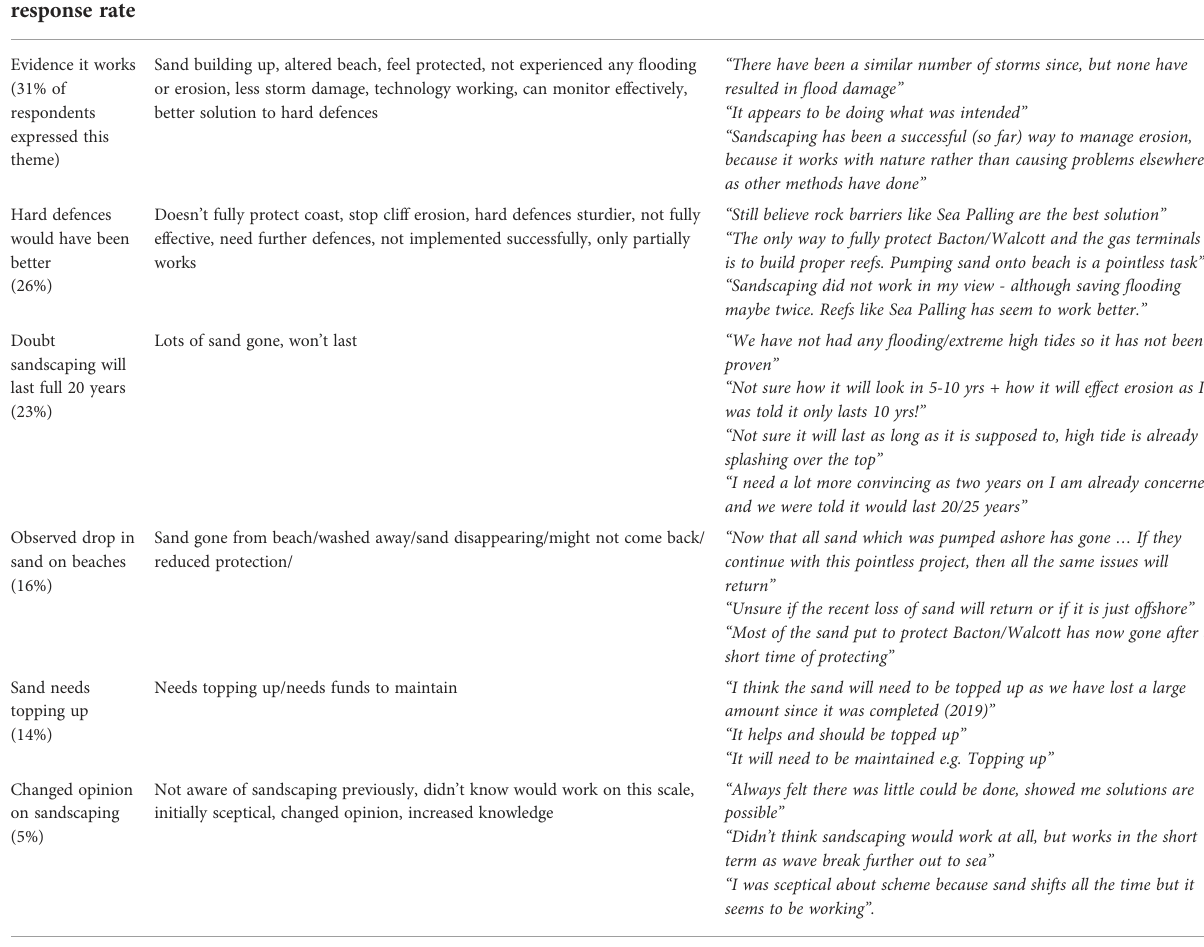
TABLE 1 Thematic analysis of answers across the survey ’ s open-ended questions, summarising any themes which relate to perceived effectiveness of the sandscaping scheme (similar codes grouped together). Theme